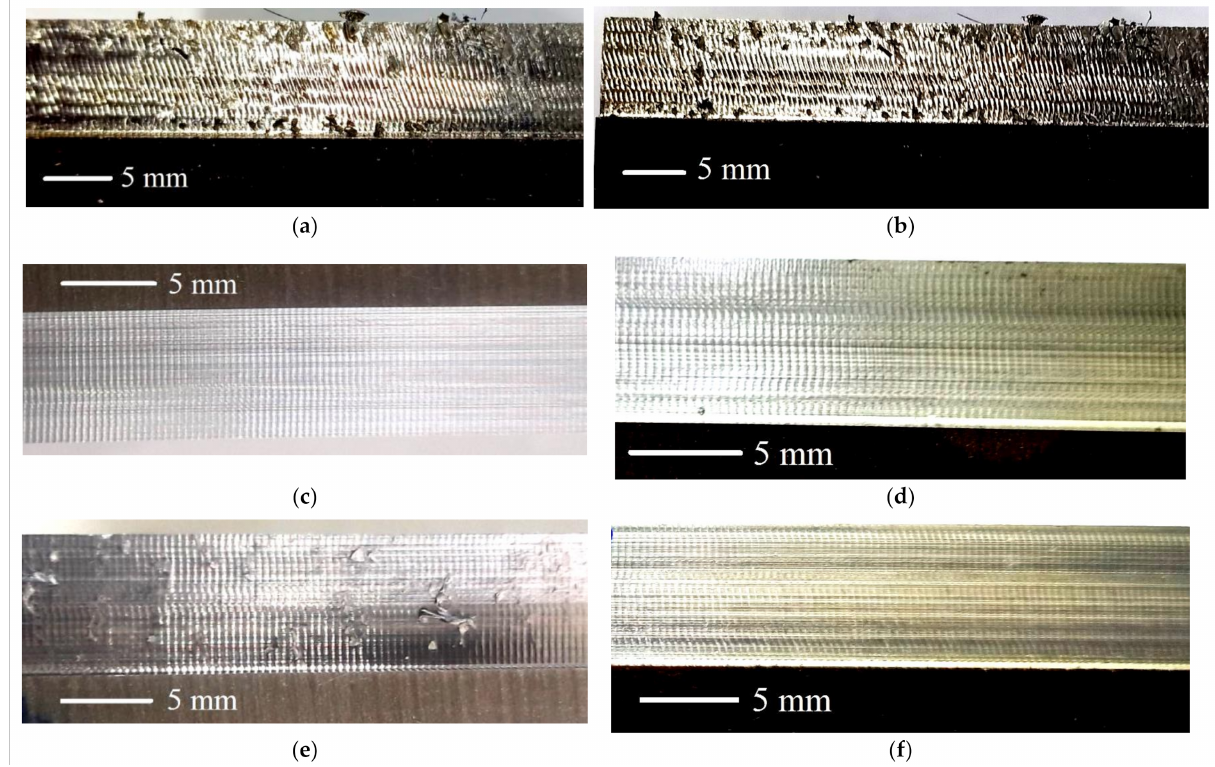
Figure 6. Magnified views of the milled surfaces generated in the following runs: ( a ) coolant = dry, V c = 50 m/min; ( b ) coolant = evaporative, flow rate = 0.2 kg/min, V c = 50 m/min; ( c ) coolant = evaporative, flow rate = 0.4 kg/min, V c = 150 m/min; ( d ) coolant = evaporative, flow rate = 0.6 kg/min, V c = 200 m/min; ( e ) coolant = throttle, flow rate = 0.2 kg/min, V c = 50 m/min; and ( f ) coolant = throttle, flow rate = 0.6 kg/min, V c = 200